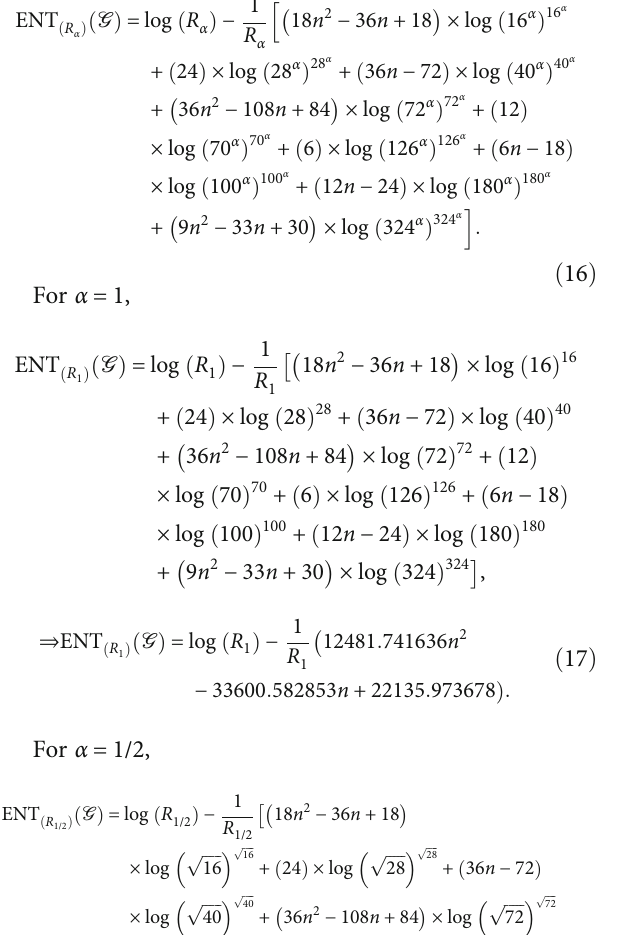
Figure 4: Randic ’ entropy for α = − 1